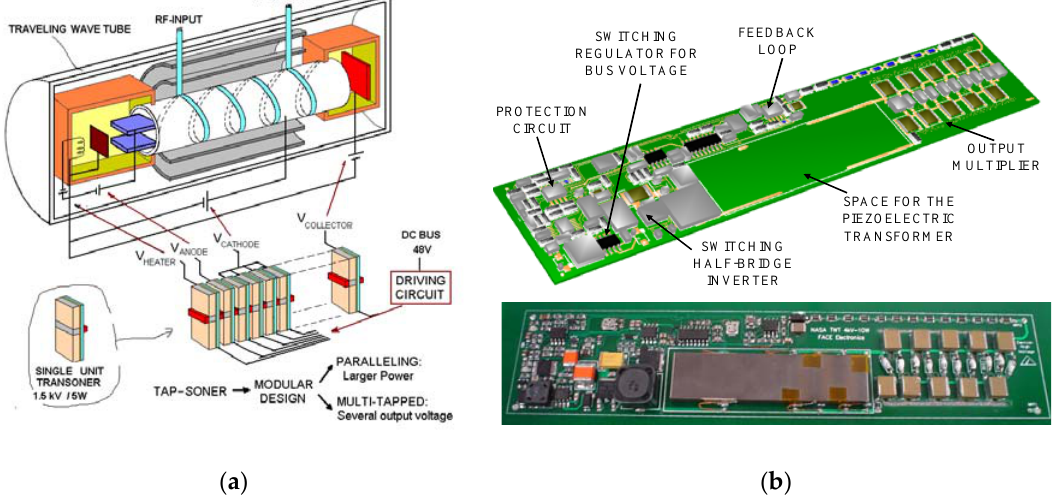
Figure 20. ( a ) Modular concept using Transoner technology applied to a traveling wave tube (TWT); ( b ) Detail of a 4 kV/10 W cathode power supply using piezoelectric transformer.